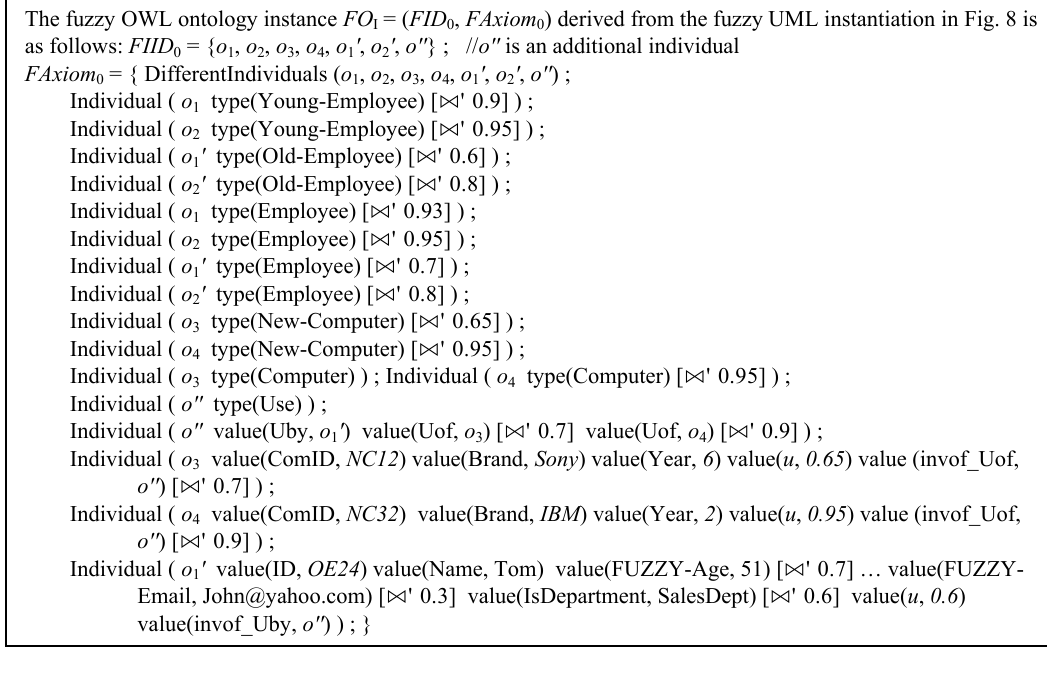
Fig. 10. The fuzzy OWL ontology instance derived from the fuzzy UML instantiation in Fig. 8.